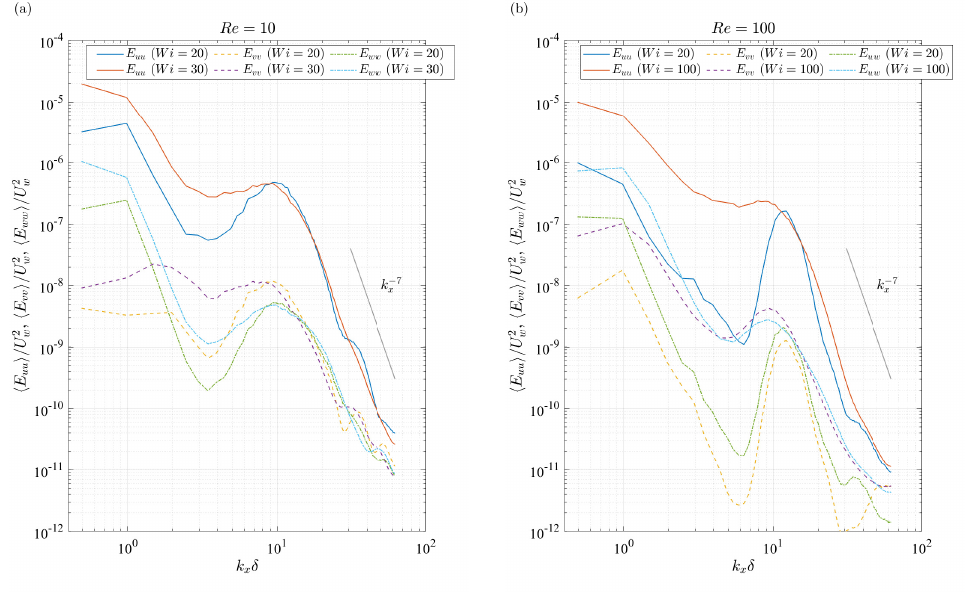
Figure 17. Longitudinal one-dimensional energy spectra of the velocity fluctuation as a function of k x for ( a ) Re = 10 and ( b ) Re = 100 with varying Wi . The solid lines represent E uu , dashed lines E vv , and dash-dotted lines E ww